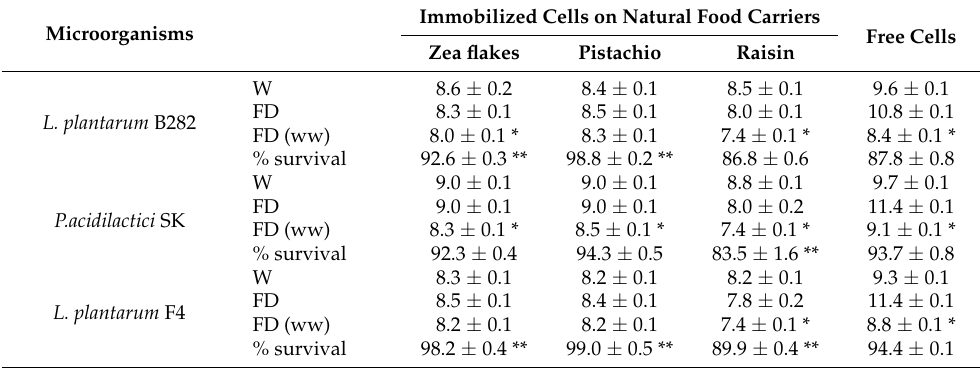
Table 1. Effect of freeze-drying and cell immobilization on cell levels and survival rates. Microorganisms